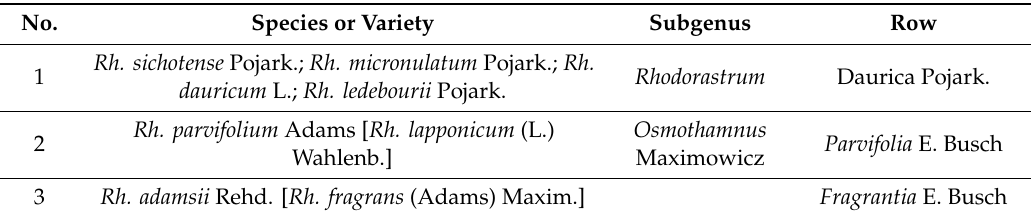
Table 1. Classification of genus Rhododendron